Question: Draft a figure caption describing what is shown.
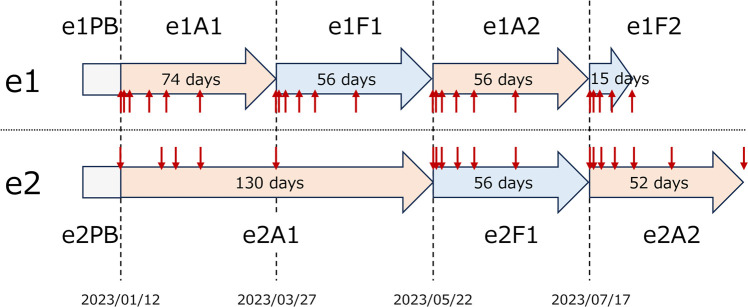
Answer: Overview of the fish translocation experiments between the aquaponics system and Fukada Pond. Two independent experiments (e1 and e2) were conducted with repeated moves. Sampling days are indicated by red arrows; sampling details at each translocation interval are in Table S1 . A total of 117 skin mucus samples and 39 environmental water samples were used, based on sampling over 23 days in e1 and 18 days in e2 ( Table S1 ). The sample IDs of the total 156 samples were named by combining “Experiment_day_group_fish with the number of the biological replicate.”